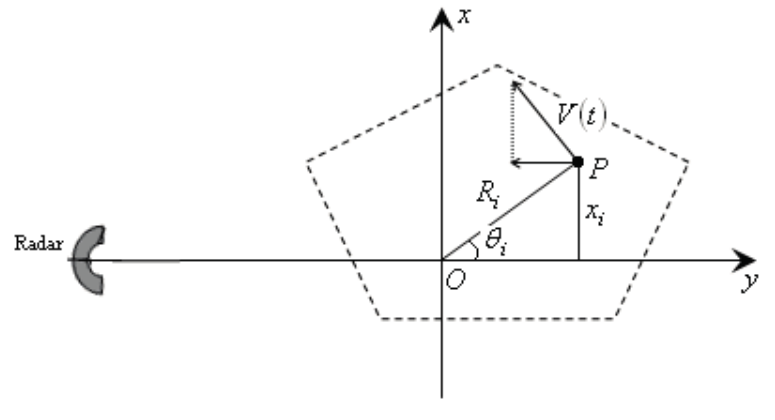
Figure 1. Geometry of radar image of maneuvering